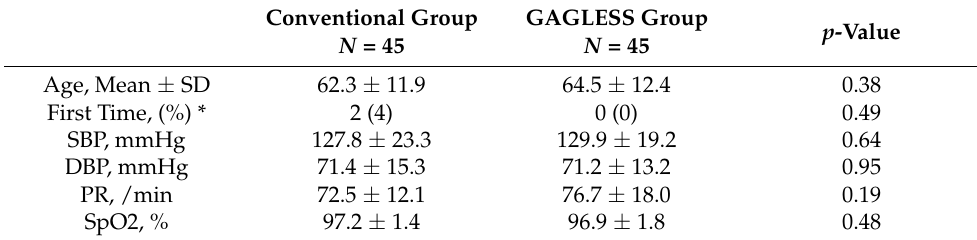
Table 1. Patient characteristics.